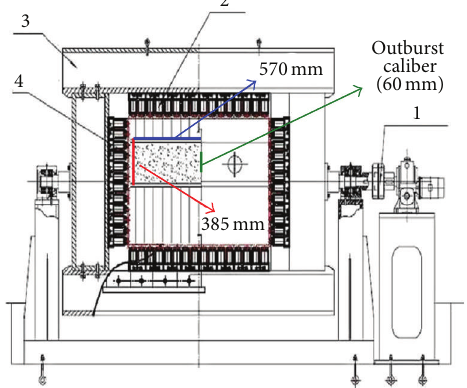
Figure 1: Structure of coal and gas outburst simulation test bed. (1) Revolving gear, (2) hydrostatic trigger, (3) bearing frame, and (4) coal